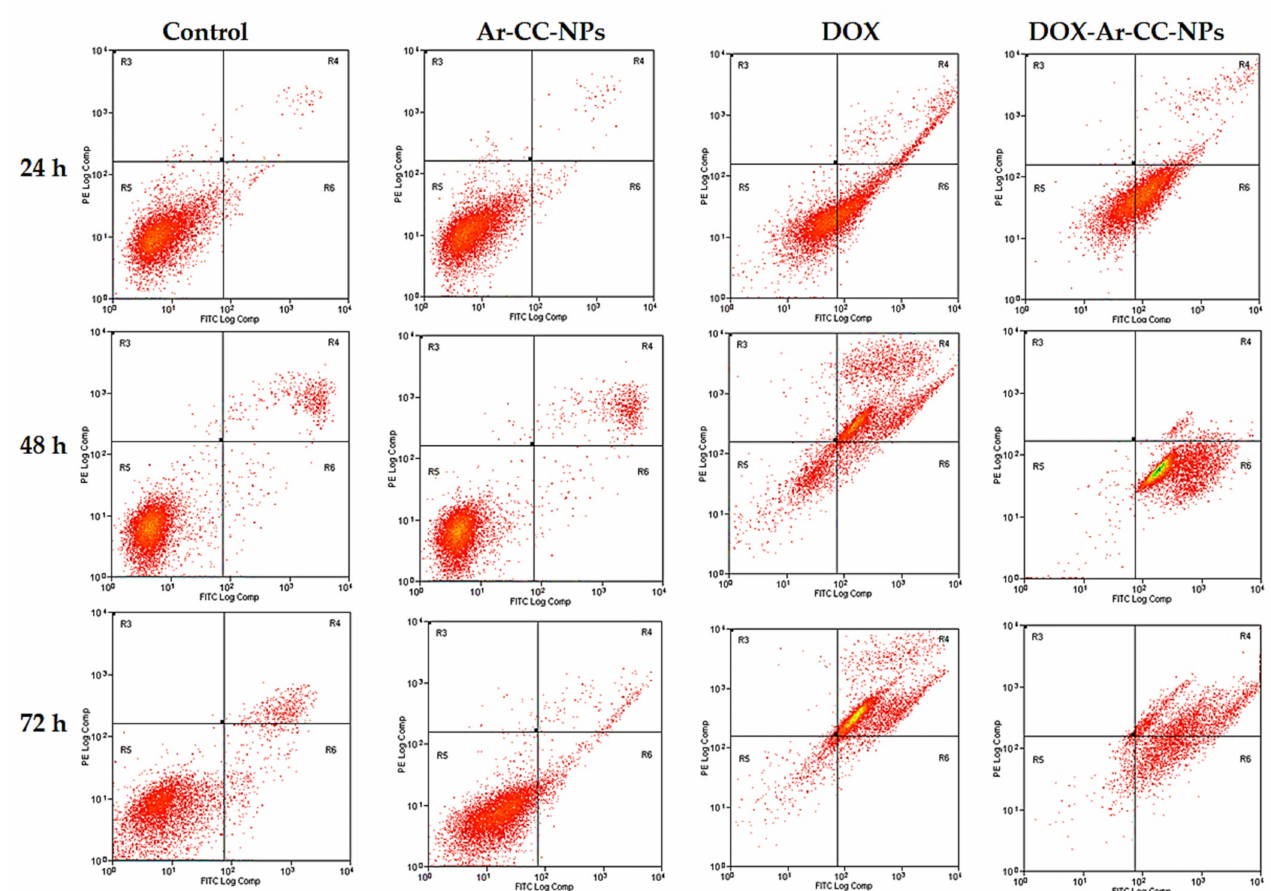
Figure 5. Annexin V assays of MCF-7 cells for 24 h, 48 h, and 72 h, respectively. Table 1. Annexin V/(PI) apoptosis assay of MCF-7 cancer cells for 24, 48 and 72 h treatment in different groups. The left lower (LL) quadrant represents viable cells, Left-Right (LR) Quadrant represent early apoptosis, Under Right (UR) Quadrant represent late apoptosis while the Under Lower (UL).